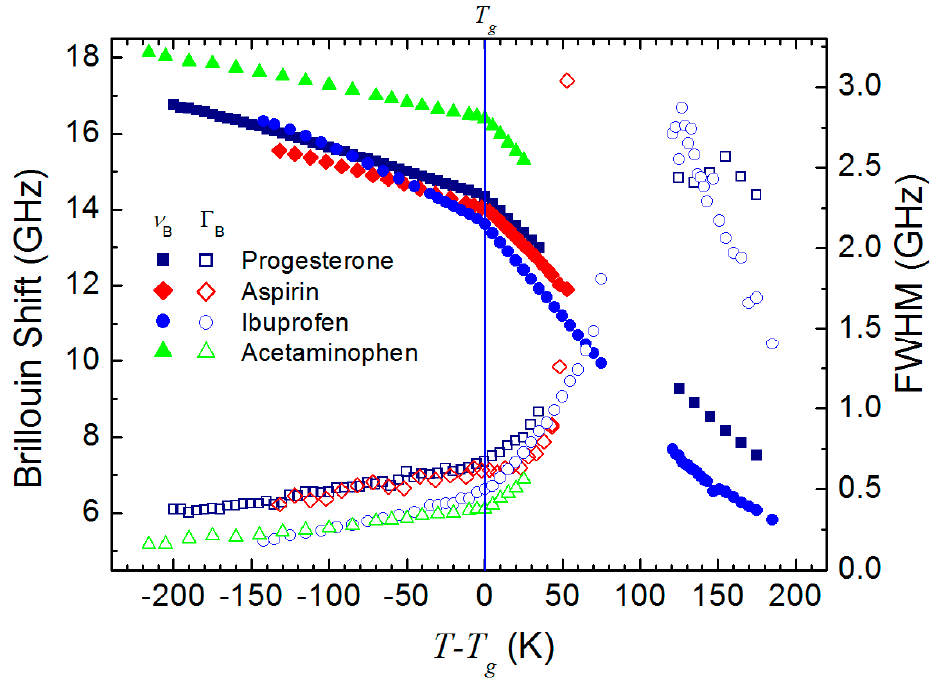
Figure 5. Comparison of the Brillouin shift ( ν B ) and the full width at half maximum (FWHM, Γ B ) of four representative pharmaceuticals. The temperature scale is shown with respect to T g .